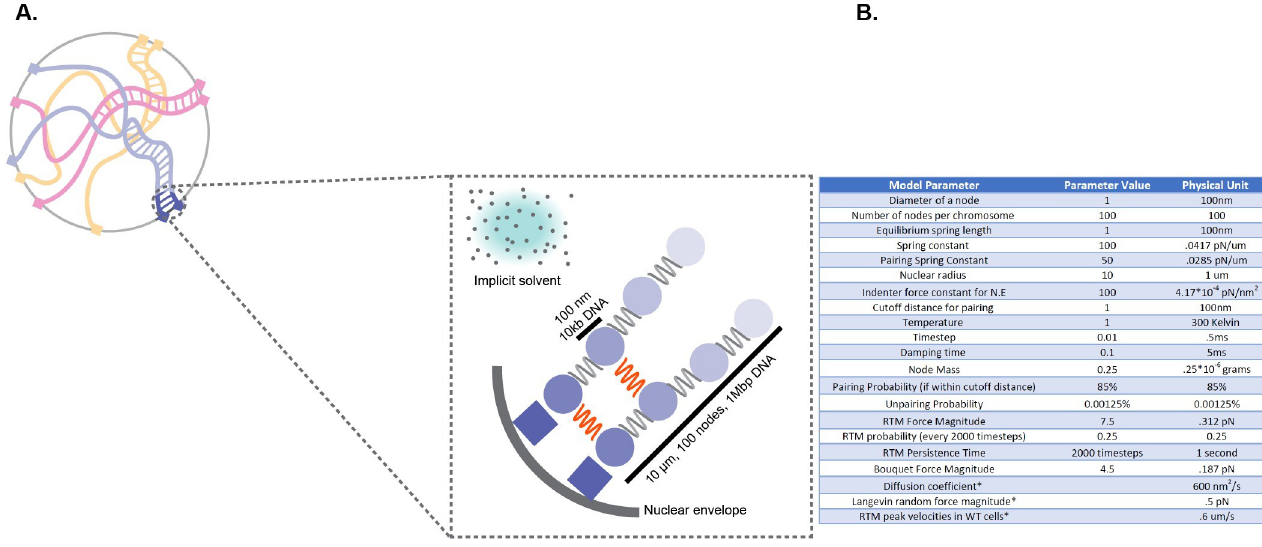
Fig 2. Simulating Meiotic Chromosome Pairing (A) To model meiotic chromosome pairing, we use bead spring polymers undergoing Langevin dynamics. (B) Model parameters used in the simulation.